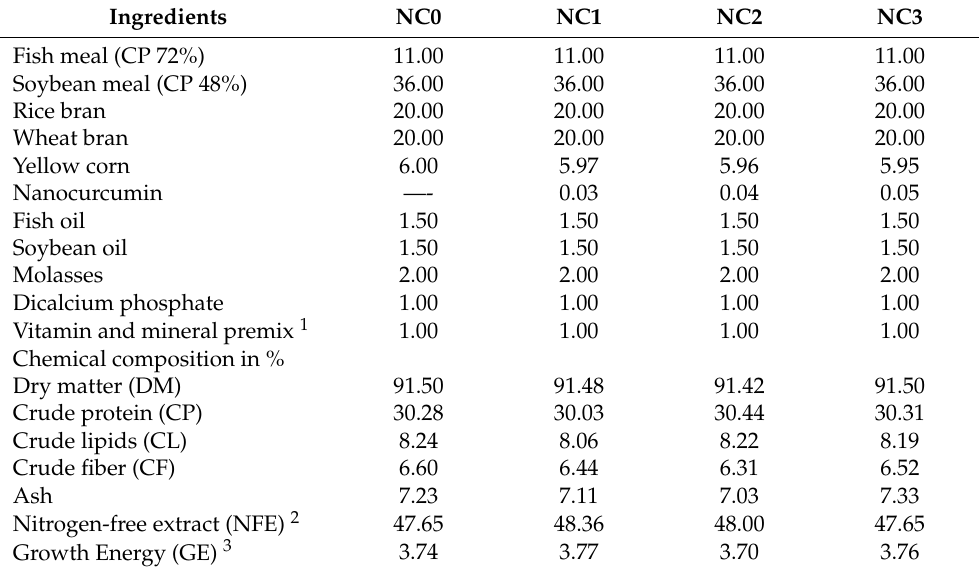
Table 1. Constituents and chemical composition of the investigational diets. NC0: control diet;